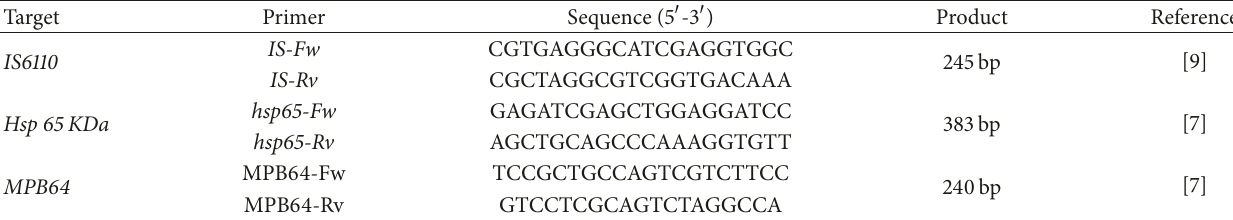
Table 1: Real time PCR targets